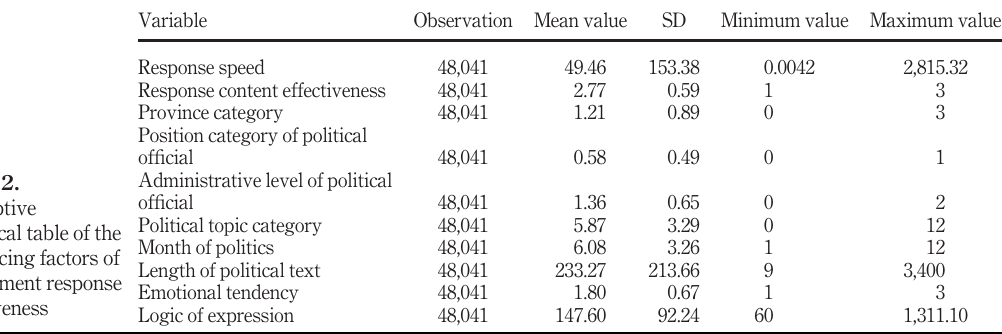
statistical table of the in fl uencing factors of government